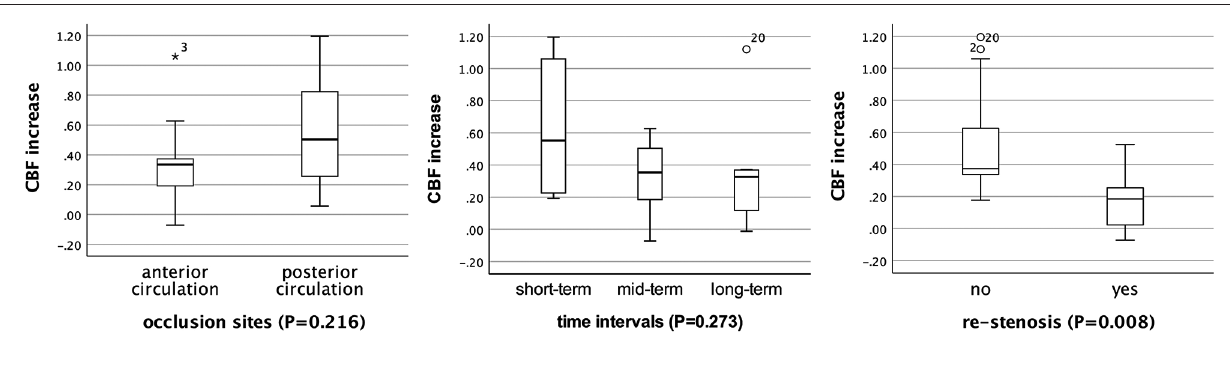
FIGURE 2 | Comparison of the proportion of relative cerebral blood flow change (rCBFc%) in patients with different occlusion sites, at different time intervals, and restenosis status. *Represents extreme value (more than three box lengths from either end of the box), and circles represent outliers (between one and a half and three box lengths from either end of the